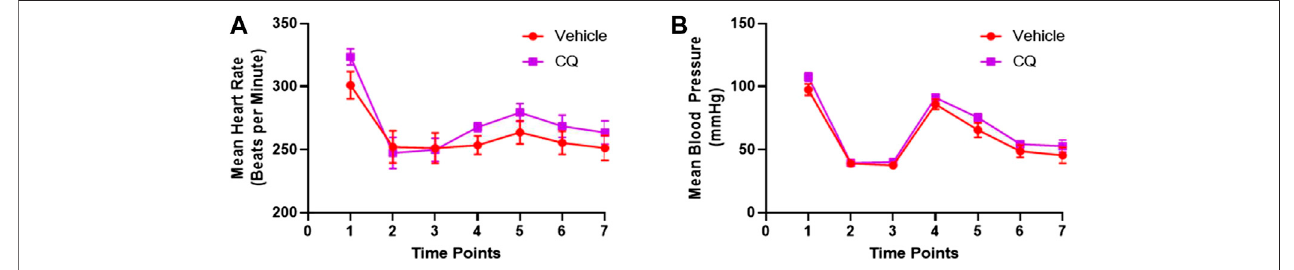
FIGURE 3 | Effect of CQ on cardiovascular activities, HR and MAP. (A, B) , a graphical representation of mean HR (A) and MAP (B) at different time points (1 – baseline, 2 – after hemorrhage, 3 – after de-clamping renal arteries, 4 – 0 min post-perfusion, 5 – 30 min post perfusion, 6 – 90 min post-perfusion and 7 – 120 min post- perfusion). Data represents mean ± SEM values. N (cid:1) 7 for vehicle and N (cid:1) 8 for CQ. Statistical analysis – unpaired t